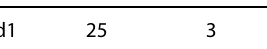
Table 2 Detail of defects introduced in the panel